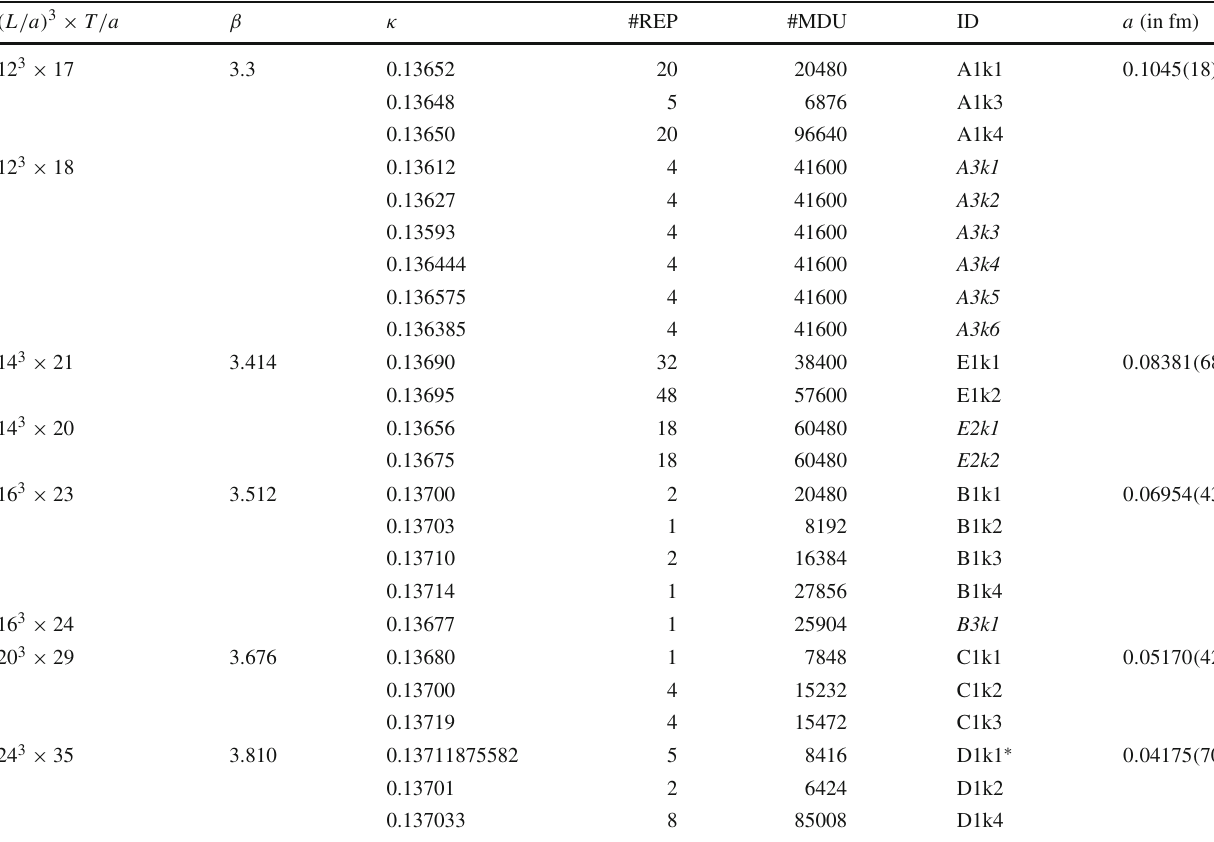
Table 1 Simulation parameters L , T , β , κ , the number of replica #REP and the number of molecular dynamics units #MDU for the ensembles labelled by ID. Ensembles highlighted in italics were newly generated for this study while the remaining ones were already used in previous investigations (see, for example Ref. [14]). The ensemble D1k1 marked